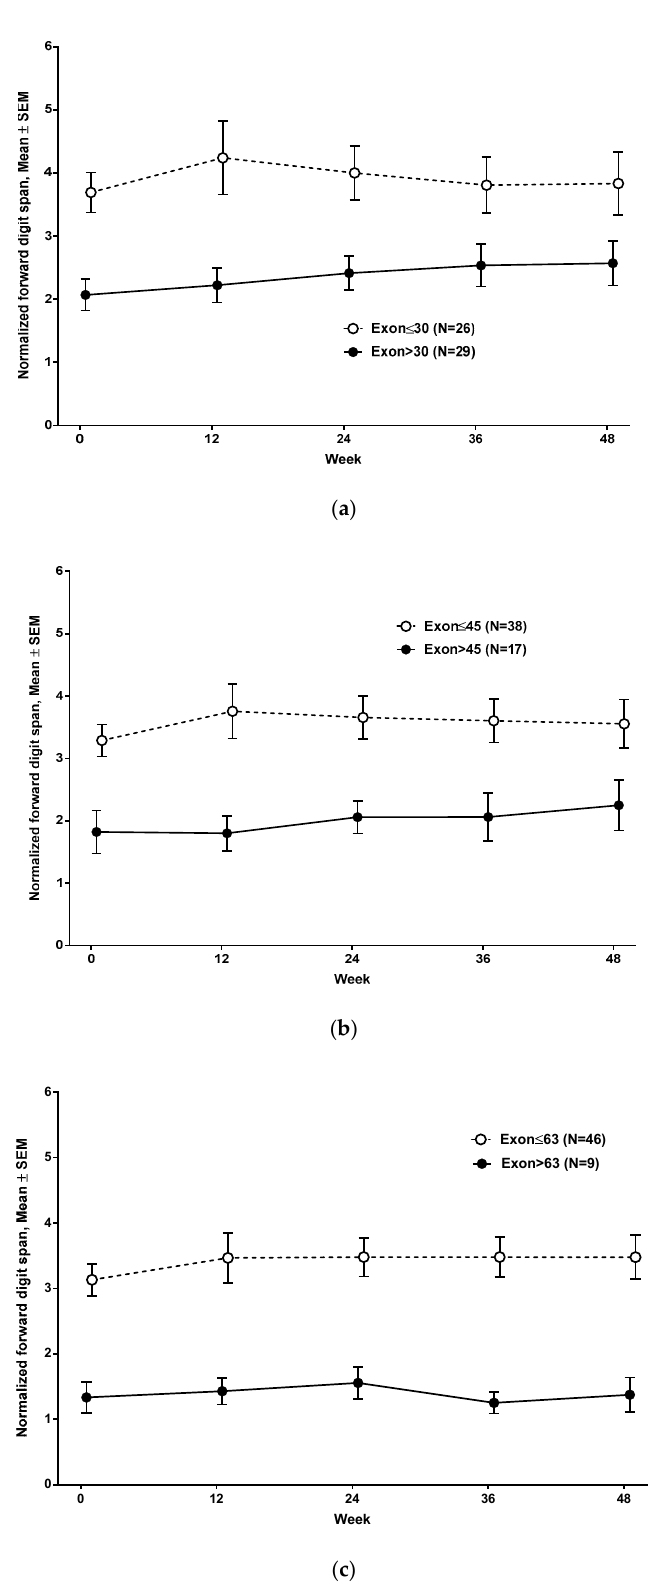
Figure 3. ( a – c ) Forward digit span based on nonsense Duchenne muscular dystrophy (nmDMD) mutation